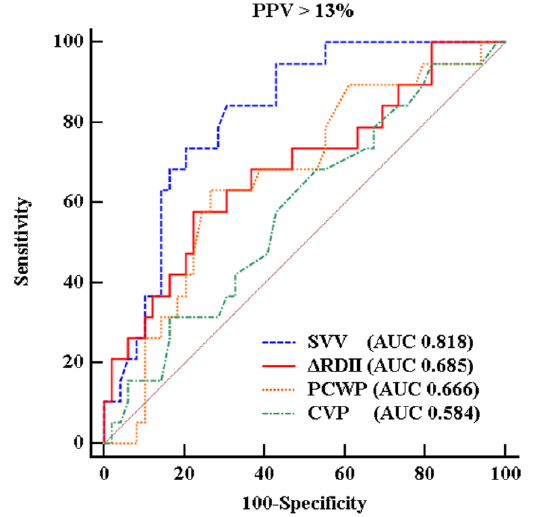
Figure 2. Receiver operating characteristic (ROC) curves. Ability of variation of R-wave amplitude in lead II ( Δ RDII) to predict a pulse pressure variation (PPV) > 13% (a sensitivity, 57.9% and a specificity, 77.6%). Stroke volume variation (SVV) showed a sensitivity of 81.3% and a specificity of 83.3%. Pulmonary capillary wedge pressure (PCWP) and central venous pressure (CVP) had a sensitivity of 31.3%, 68.4% and a specificity of 83.3% and 55.6%.